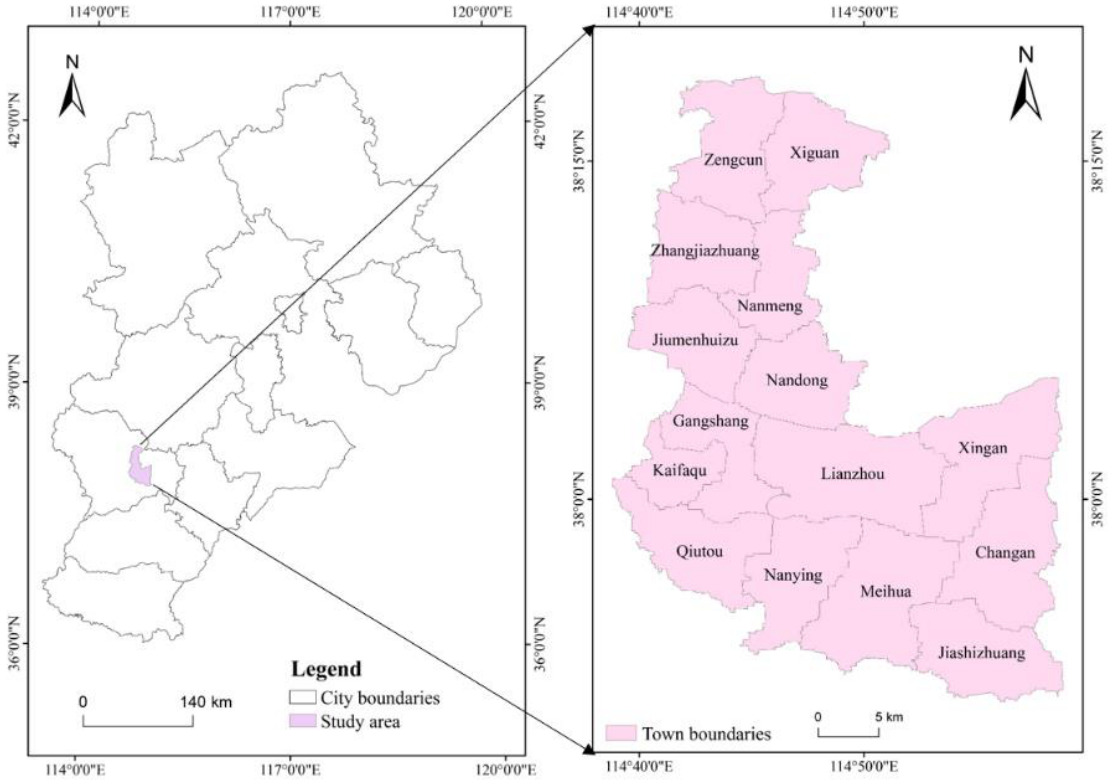
Figure 1. Geographical location of the study area and distribution map of town.